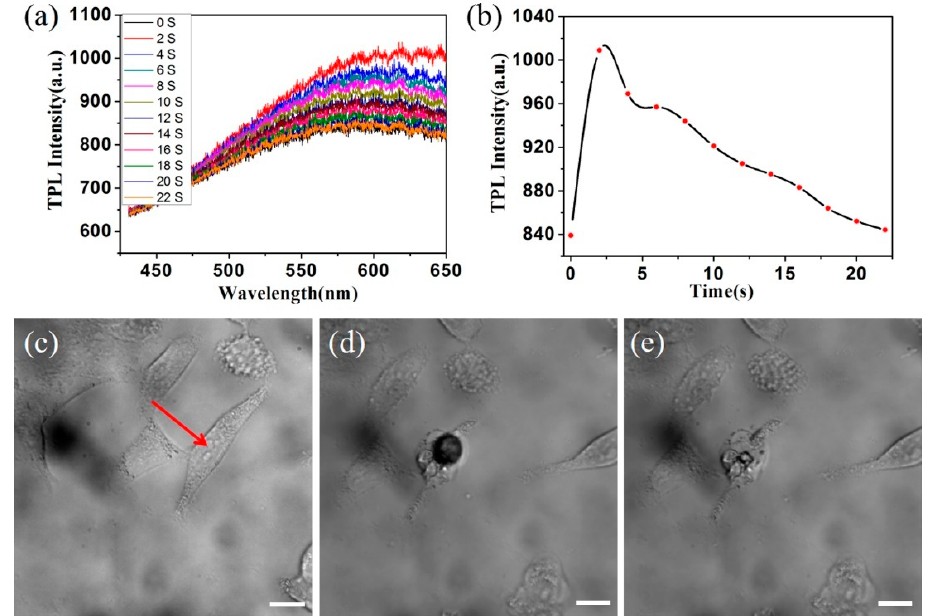
0.4, 0.5, 0.6, 0.7, 0.8, 0.9, and 1.0 s, respectively. The length of the scale bar is 20 μ m.